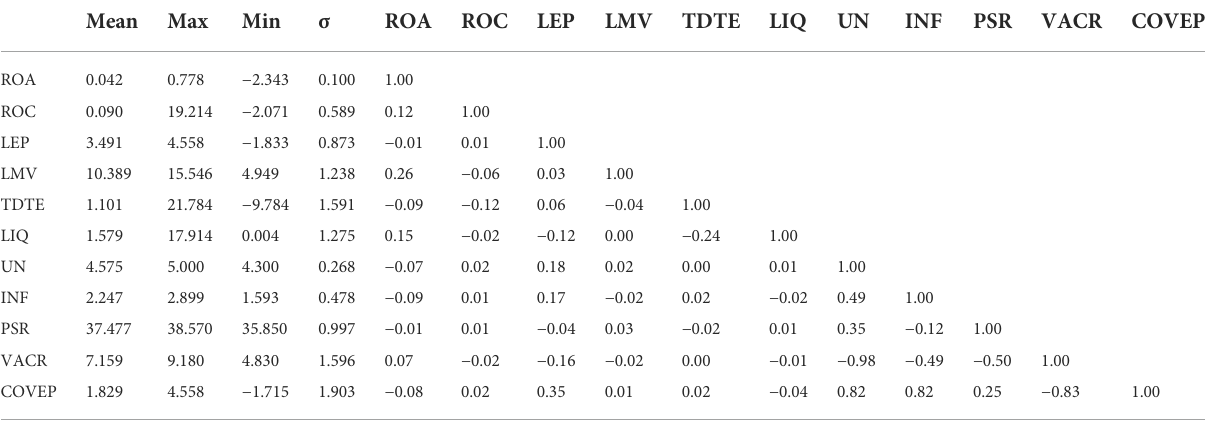
TABLE 1 Descriptive statistics and correlation